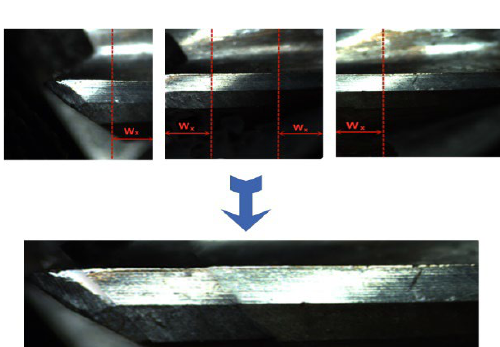
Figure 5. Partial view of cutting edge after splicing.